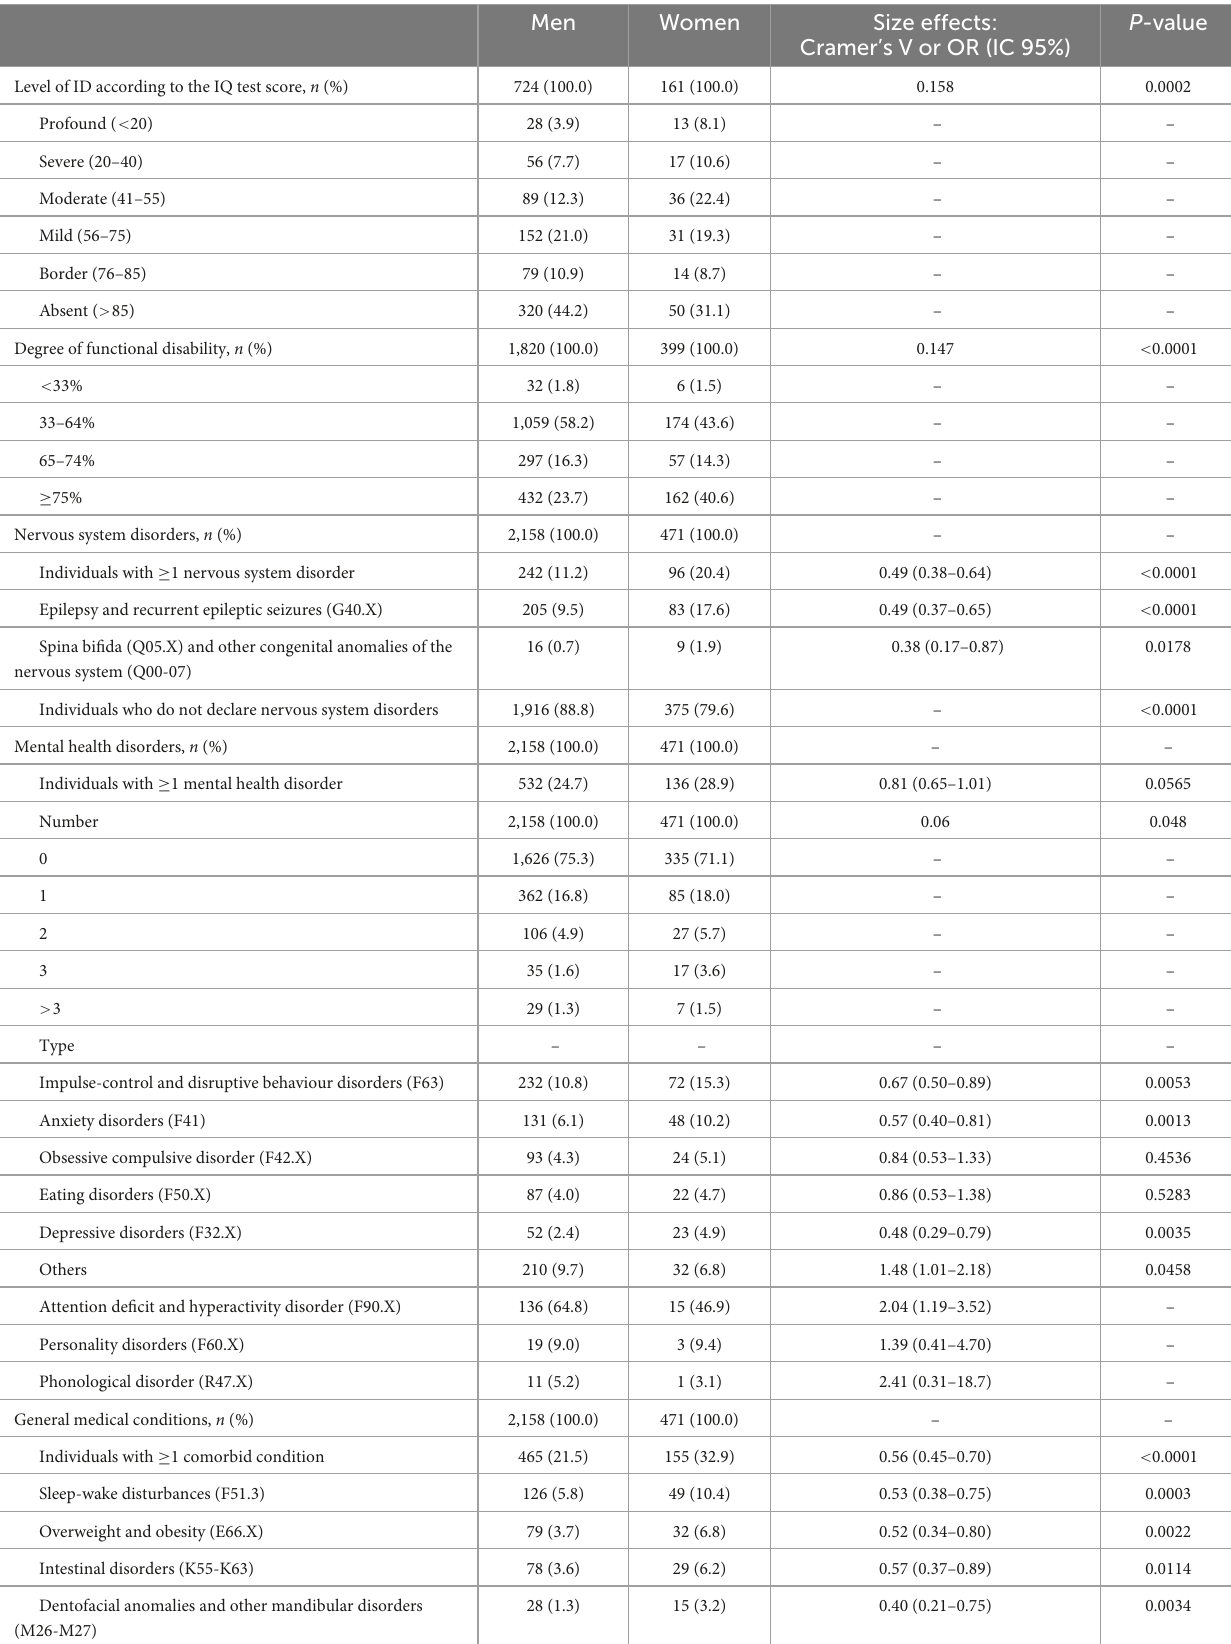
TABLE 3 Intellectual and functional disability, nervous system, and mental health disorders, general medical conditions and psychopharmacological treatment according to